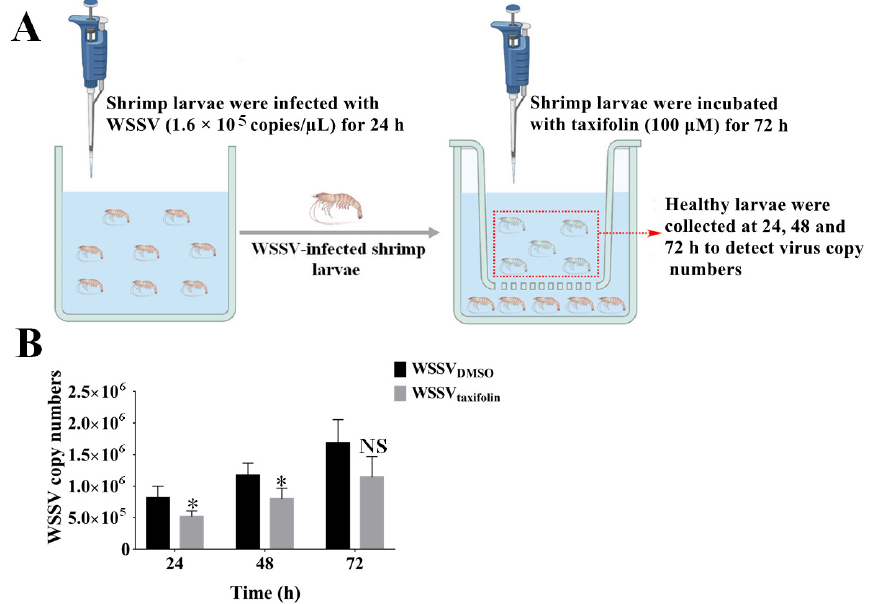
Figure 6. Taxifolin blocked the horizontal transmission of WSSV. ( A ) Schematic diagram describing the workflow. ( B ) WSSV genome copy number of shrimp larvae was tested every 24 h. Each value was represented as the mean ± SD. The p value was determined by Student’s t -tests. NS p > 0.05; * p < 0.05.